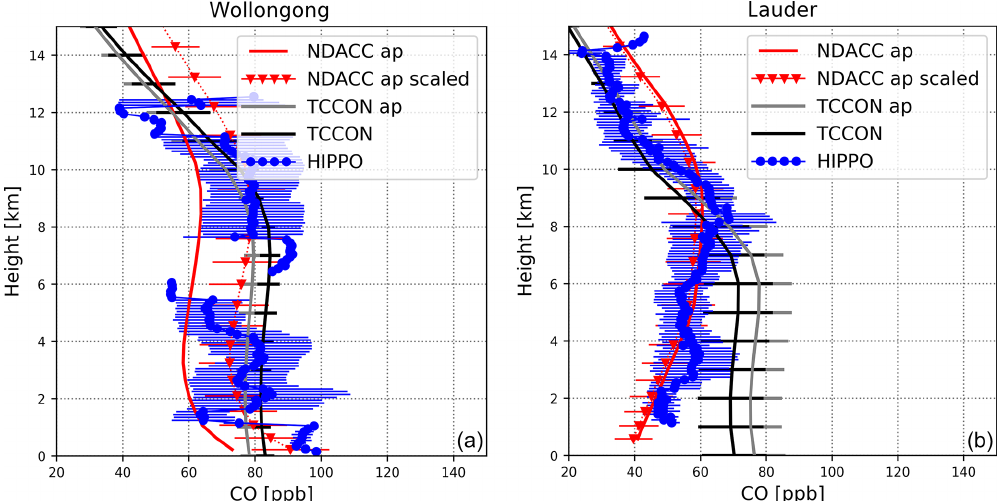
Figure 5. The vertical distribution of the NDACC a priori profile (NDACC ap), scaled NDACC a priori profiles (NDACC ap scaled), TCCON a priori profiles (TCCON ap), TCCON retrieved profiles (TCCON) and HIPPO aircraft measurements (HIPPO) in the range from surface to 15km at Wollongong (a) and Lauder (b) . The error bar is the SD for each